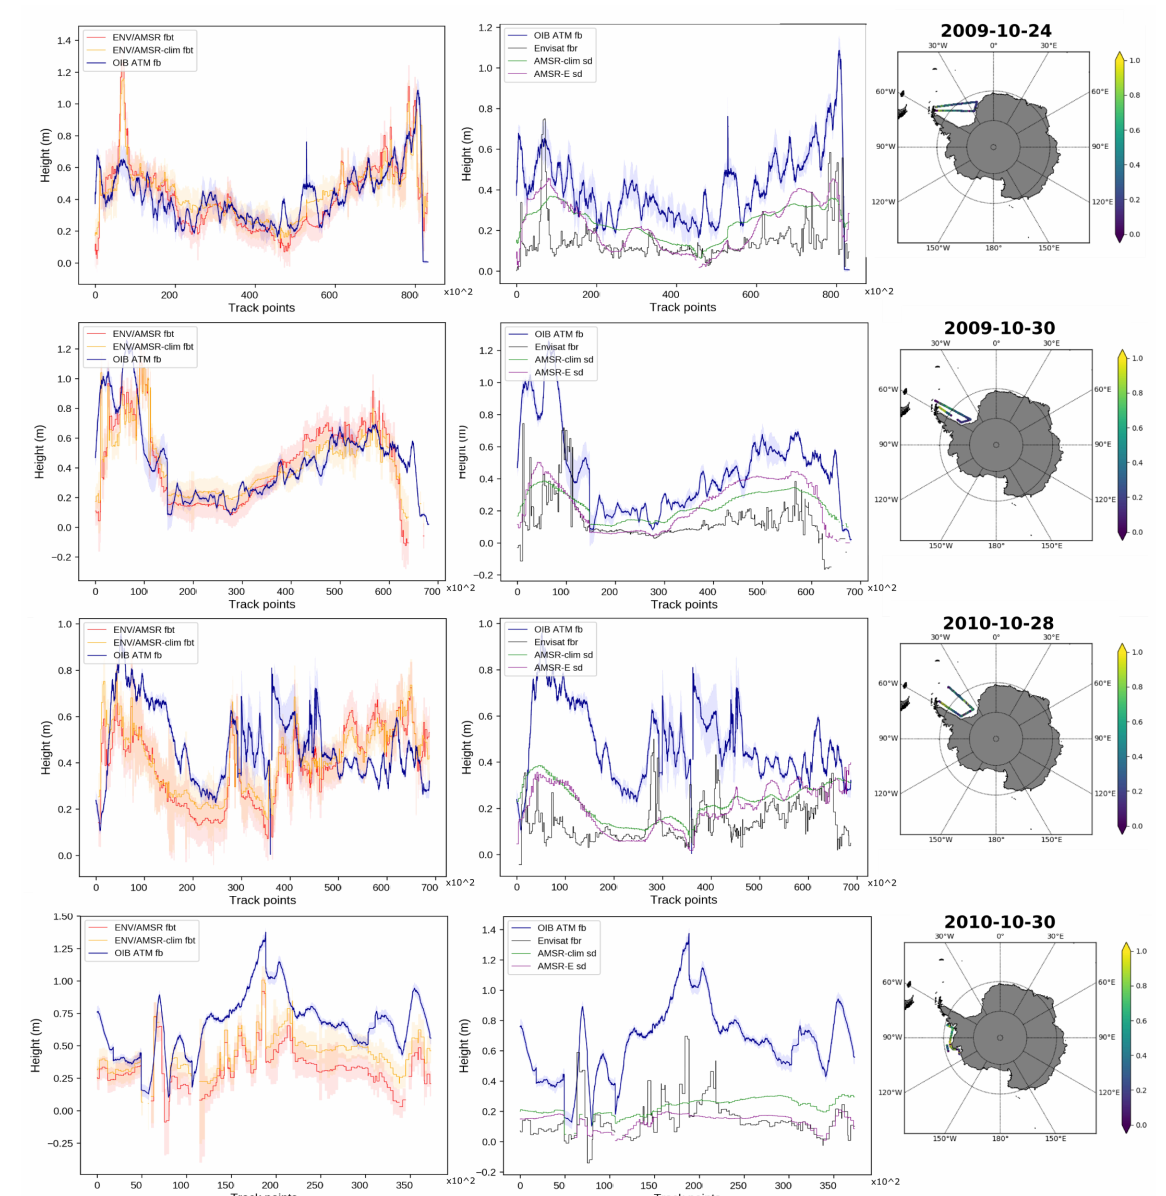
Figure A4. Same as Figure 6 for the 24 October 2009, the 30 October 2009, the 28 October 2009, and the 30 October 2010 missions.